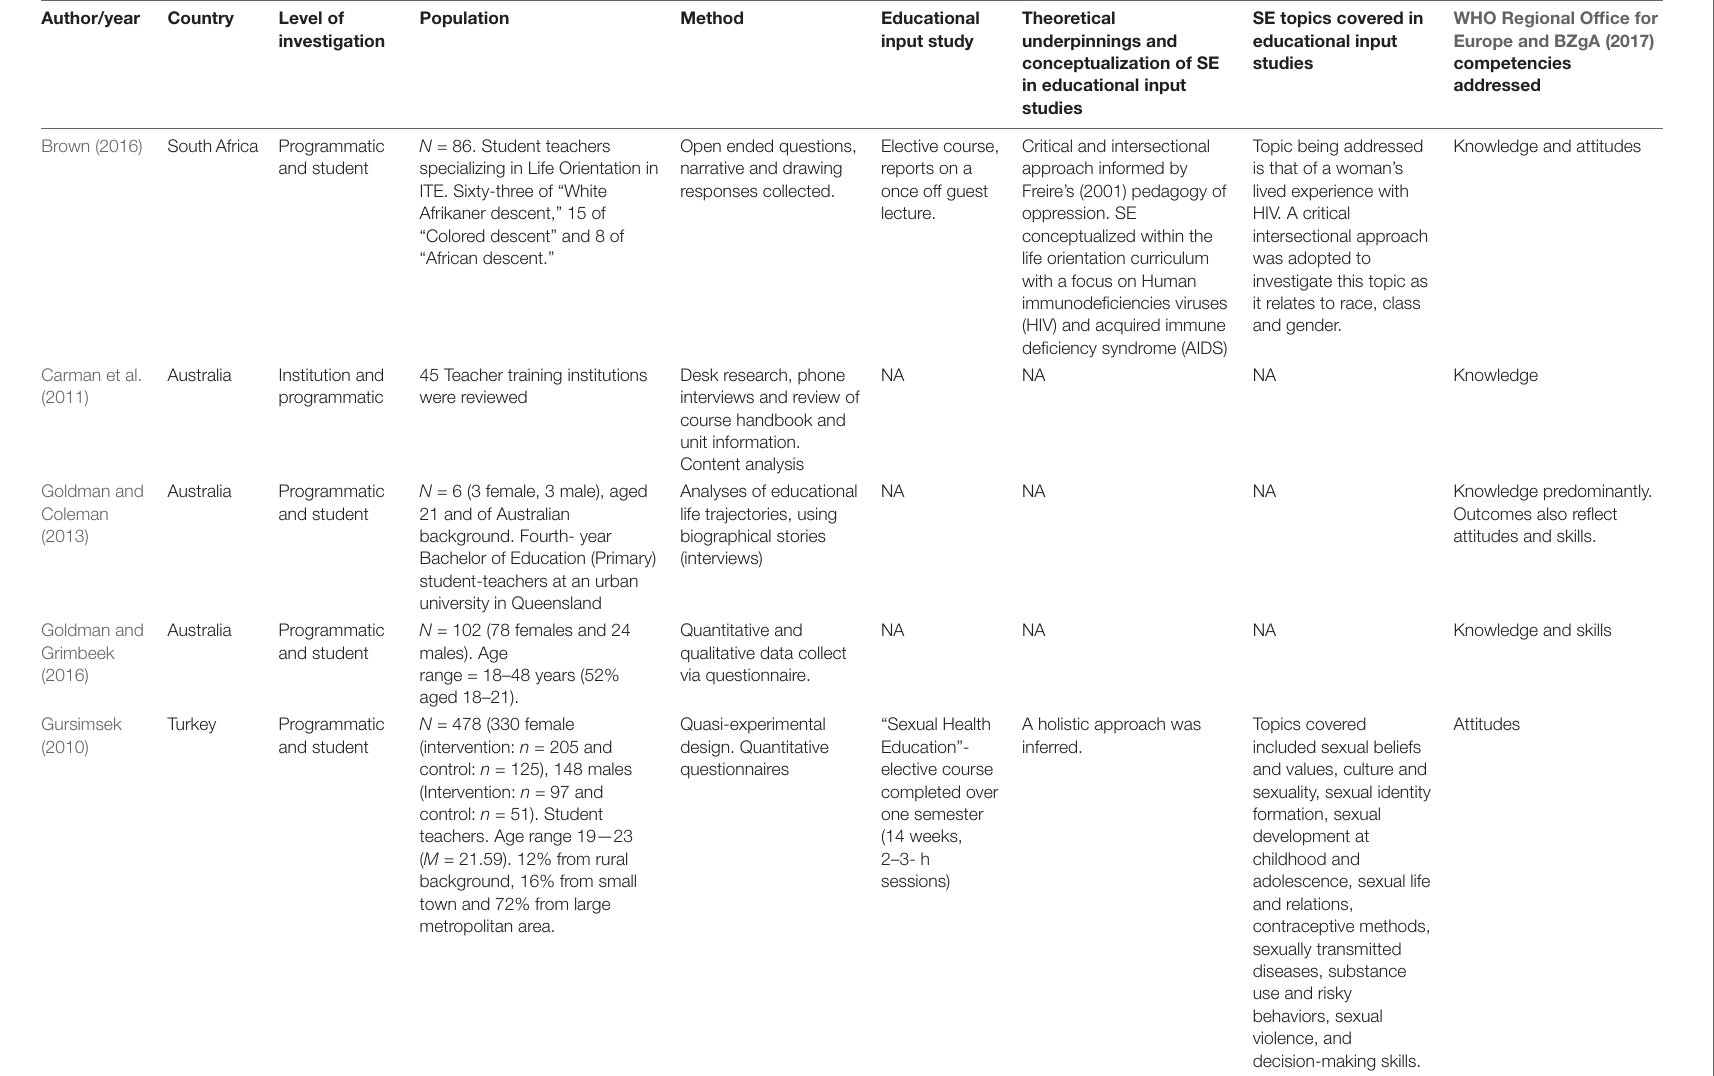
TABLE 5 | Overview of characteristics of reviewed